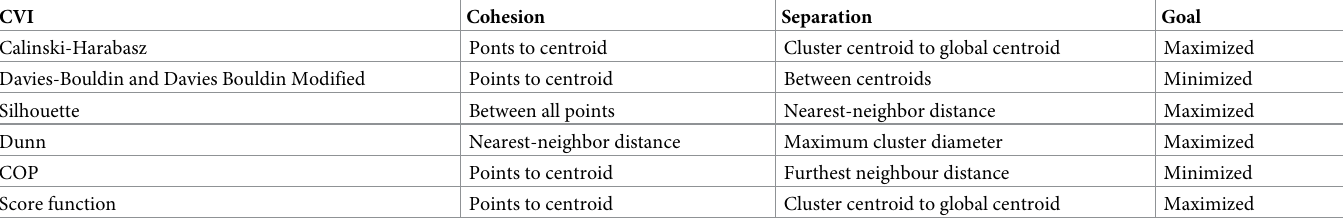
Table 1. Clustering validity indices (CVI), the distances that are used as a measure of intra-cluster cohesion or inter-cluster separation and whether their value should be maximized or minimized when choosing the most robust set of clusters. CVI Cohesion Separation Goal Ponts to centroid Cluster centroid to global centroid Maximized Points to centroid Between centroids Minimized Between all points Nearest-neighbor distance Maximized Nearest-neighbor distance Maximum cluster diameter Maximized Points to centroid Minimized Points to centroid Cluster centroid to global centroid